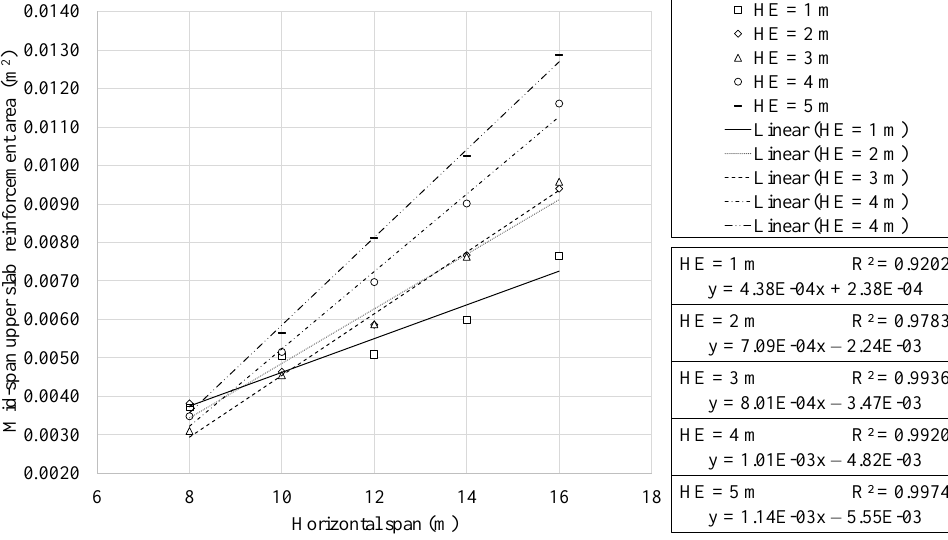
Figure 8. Upper slab mid span reinforcement area as a function of horizontal